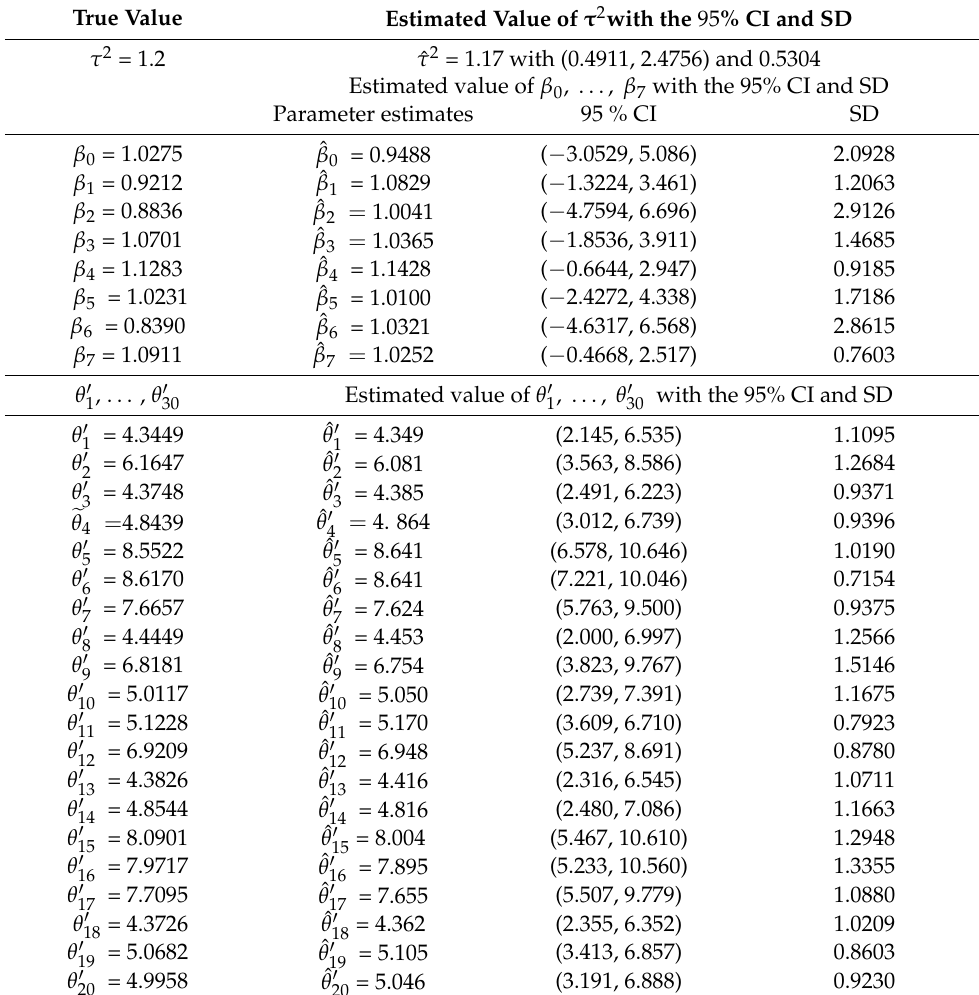
Table 3. Estimated parameters for the HBLD model using the Gibbs sampler algorithm (simu- lated data). True Value Estimated Value of τ 2 with the 95 % CI and SD τ 2 =